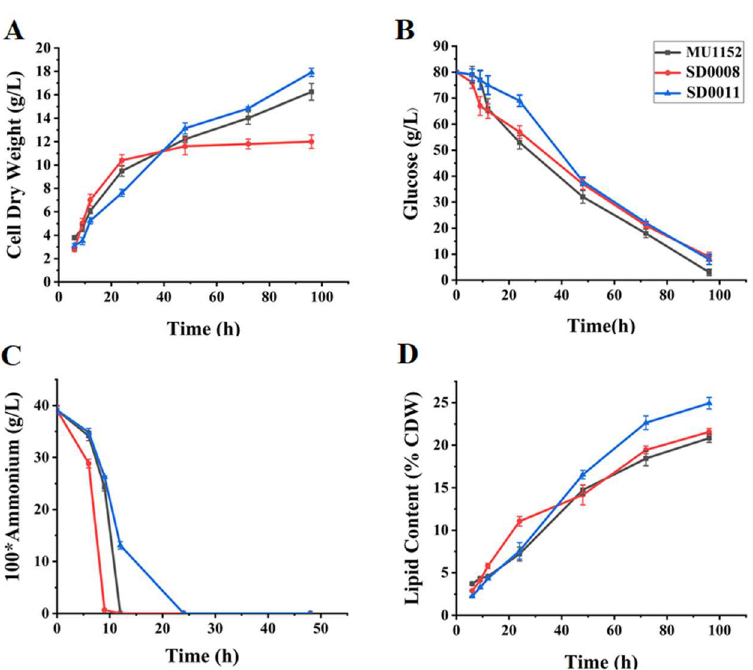
Figure 3. Transcription levels of the ada gene in the overexpressing strain SD0008, knockout strain SD0011, and the wide-type strain MU1152. Error bars represent the standard deviations.